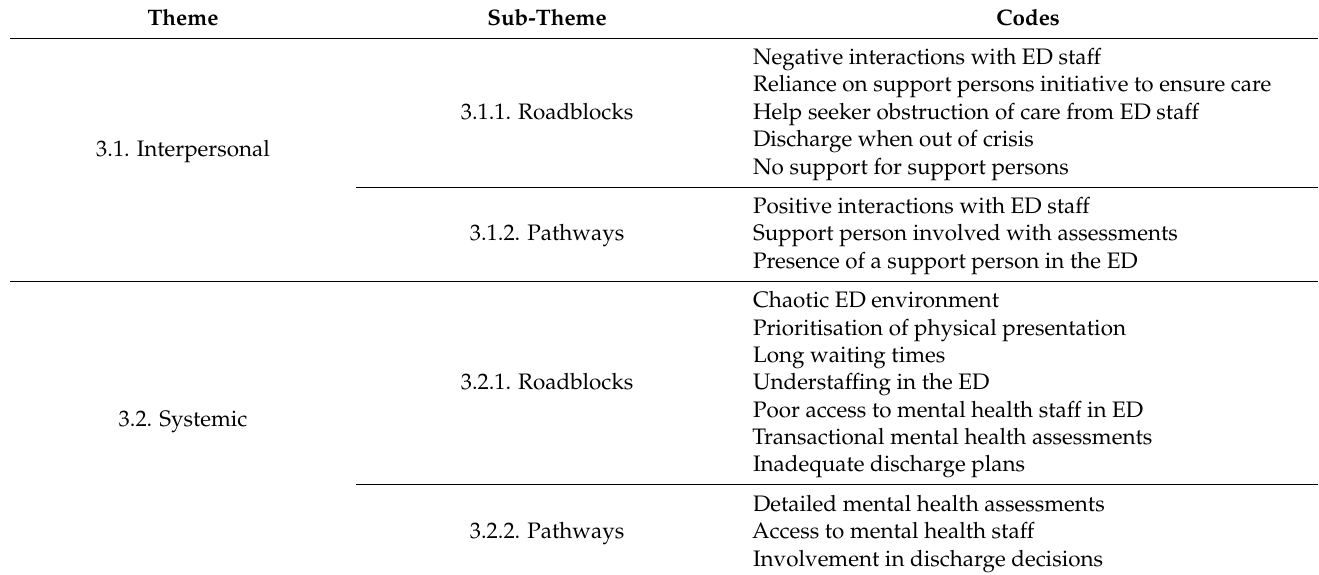
Table 1. Interpersonal and systemic pathways and roadblocks to